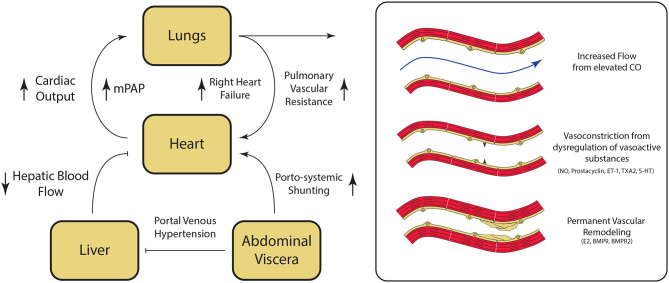
Pathogenesis of Portopulmonary Hypertension (PoPH). Hepatic fibrosis results in portal venous hypertension, increased resistance to hepatic blood flow, and splanchnic vasodilation. Splanchnic vasodilation results in increase in overal circulating volume. and the diversion of blood flow from the liver to the heart via porto-systemic shunting resulting in an overall hyperdynamic state. Dysregulation of key regulator of pulmonary vascular tone associated with cirrhosis results in pulmonary vasoconstriction. At the same time, damage to the pulmonary endothelium and the underlying smooth muscle results in permanent vascular remodeling, which ultimately leads to the development of pulmonary hypertension. CO, cardiac output; NO, nitric oxide; ET-1, endothelin-1; TXA2, thromboxane A2; 5-HT, serotonin; E2, estrogen; BMP9, Bone Morphogenic Protein 9; BMPR2, Bone Morphogenic Receptor 2. Please refer to the text for additional details.